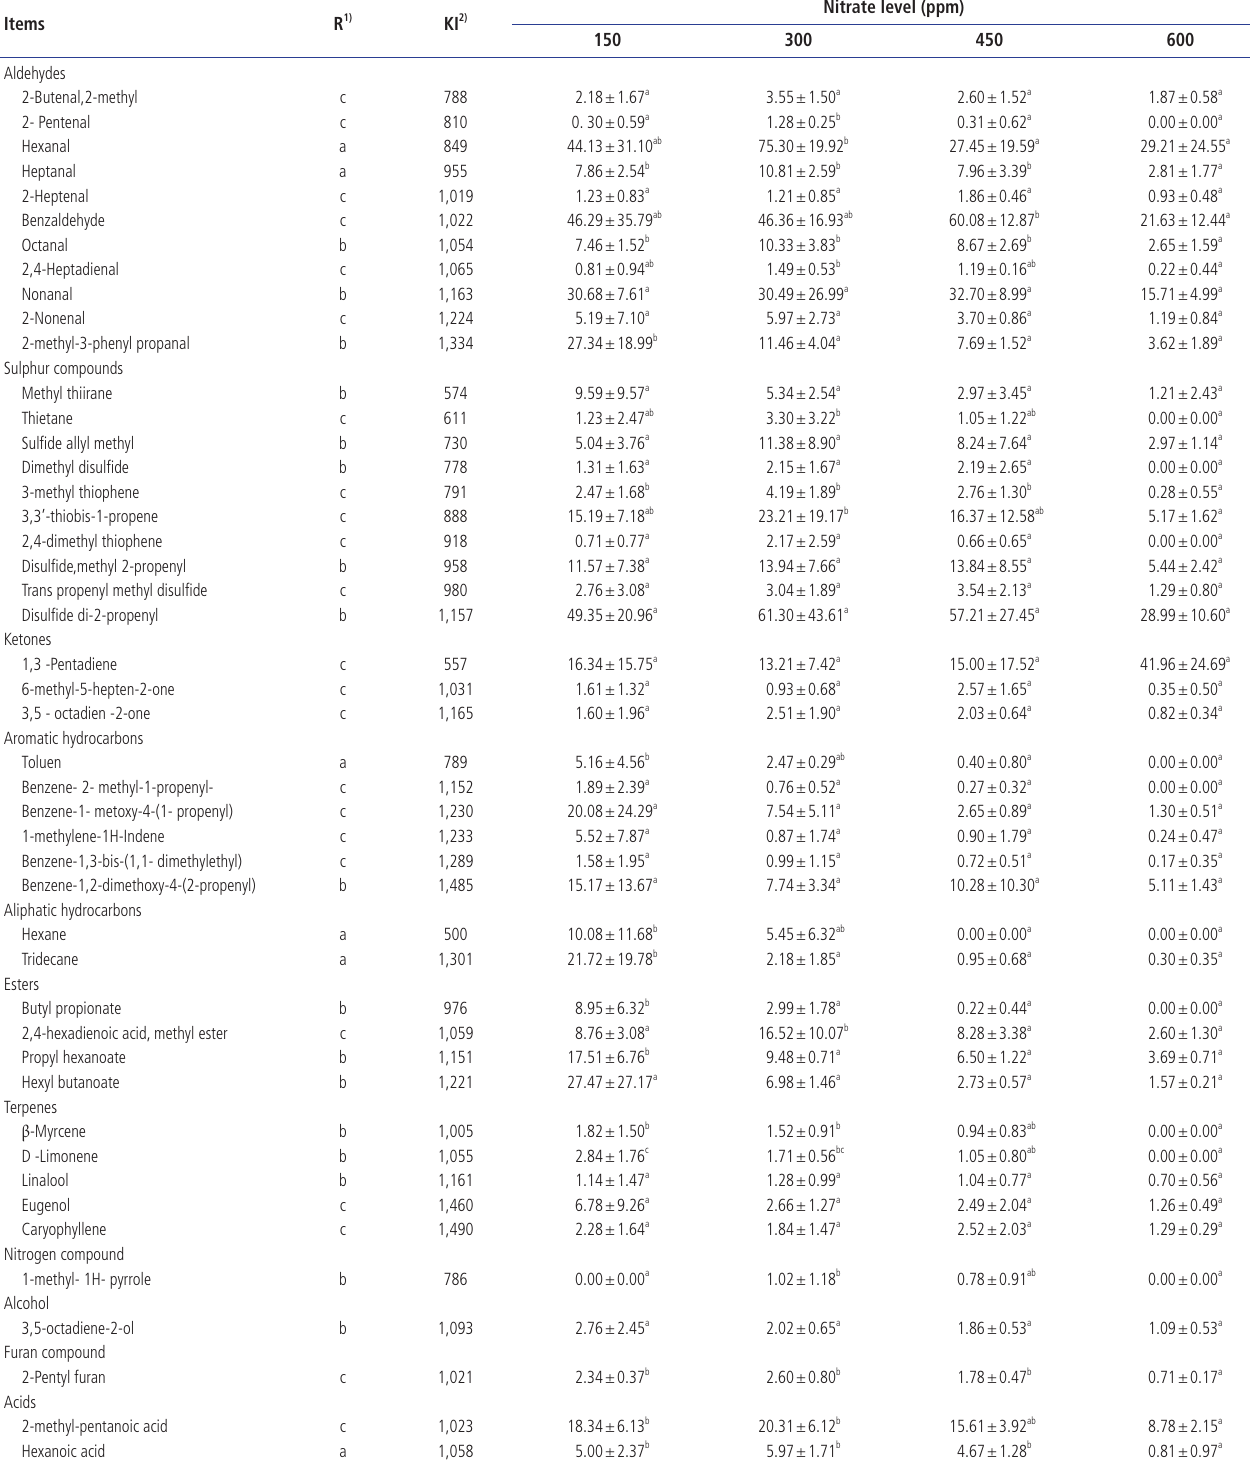
Table 3. Volatile compounds of pastırma samples produced by using different nitrate levels (values are means±SD) Items R